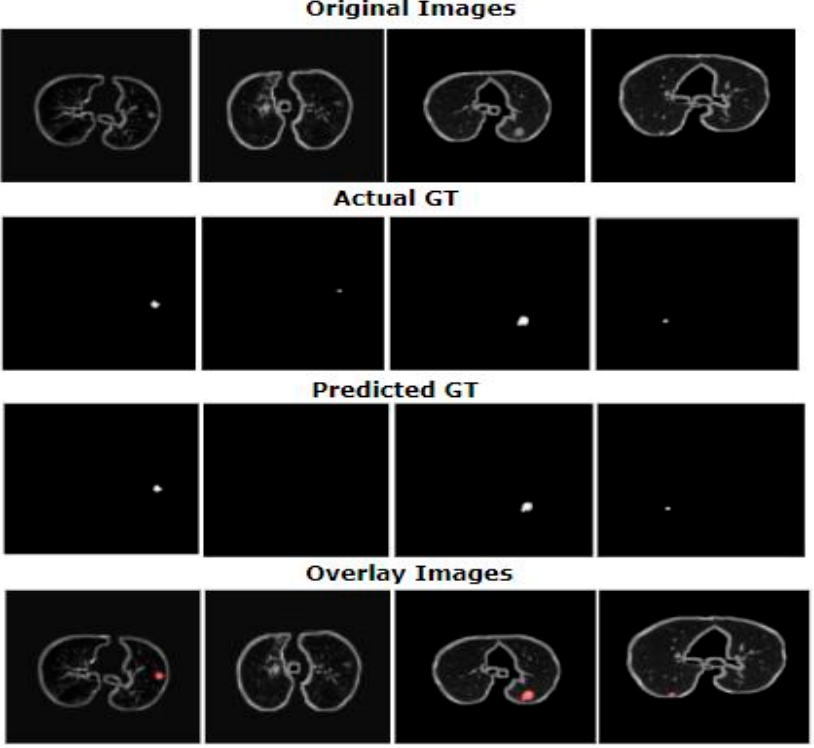
Figure 7. Segmentation results of proposed DA-Net architecture.